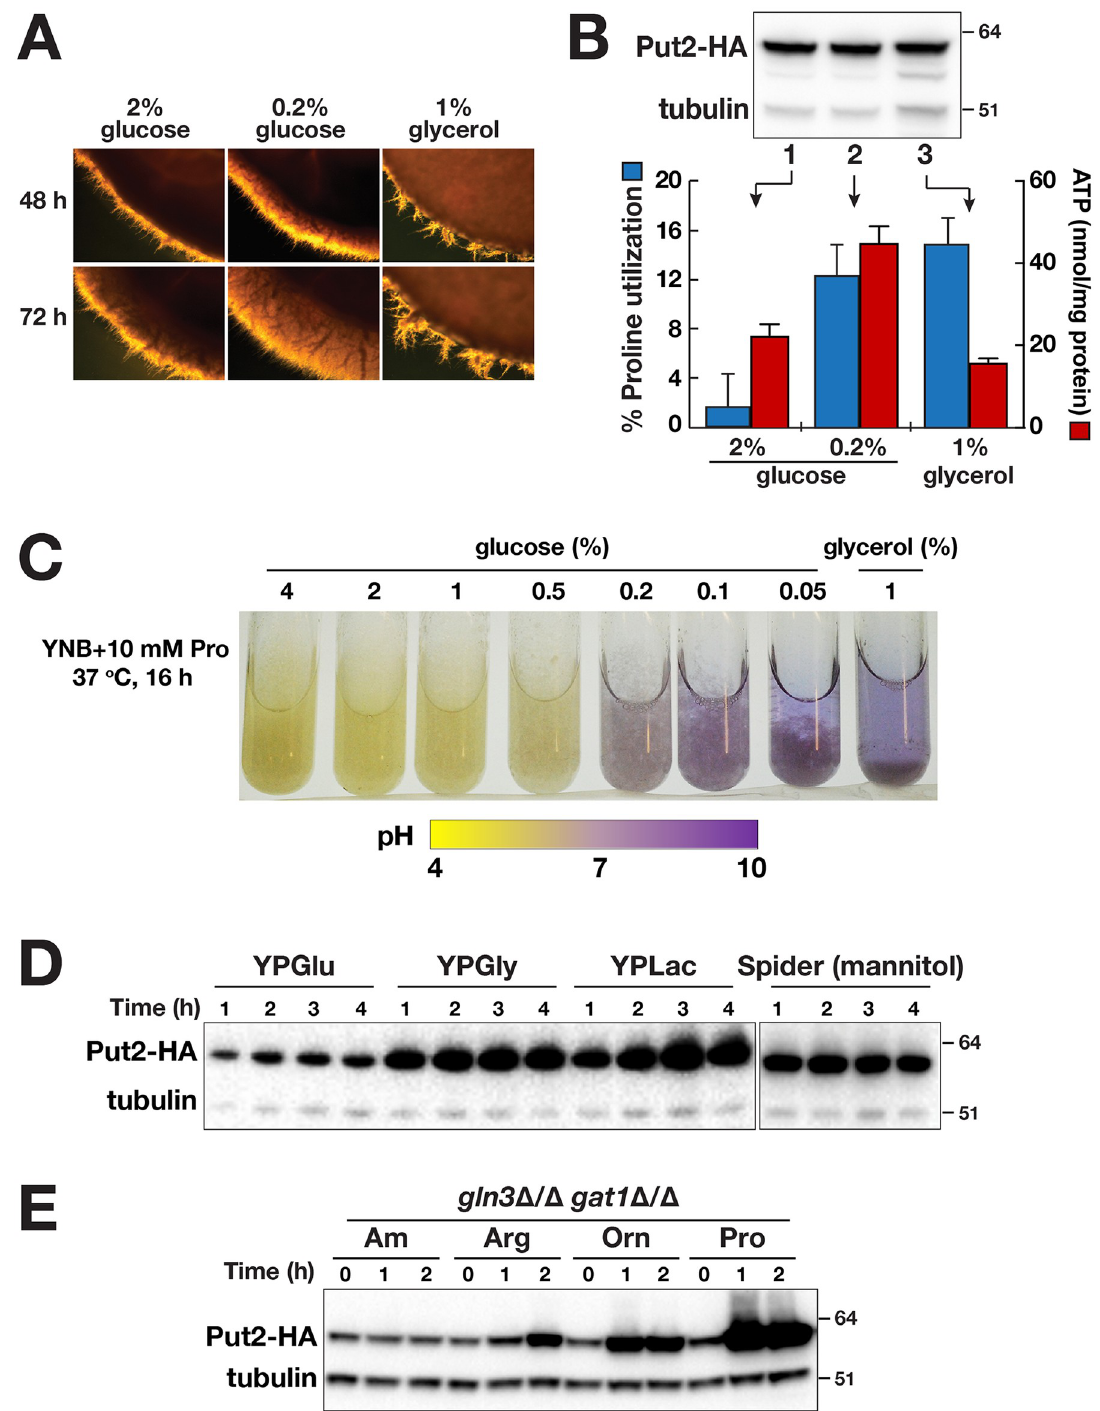
Fig 5. Proline utilization is influenced by carbon source but not by NCR. A . Filamentous growth is more robust at lower glucose level. Wildtype cells (PMRCA18) from overnight YPD liquid cultures were washed and then adjusted to OD 600 of 8, 10 μ l aliquots were spotted on media containing 10 mM of proline and the indicated levels of carbon source. Plates were incubated at 37 ˚C and photographed at 48 and 72 h. B . The rate of proline utilization and ATP levels are higher under glucose limited conditions. The levels of proline remaining in culture supernatants (blue bars, left axis) and ATP (red bars, right axis) of WT (PMRCA18) after 2 h of growth at 37 ˚C in the presence of different carbon source are indicated. Results shown are from 5 biological replicates (Ave. ± CI, 95% CL, p value < 0.001). Immunoblot analysis of Put2-HA and α -tubulin (loading control) in cell extracts prepared from CFG185 (